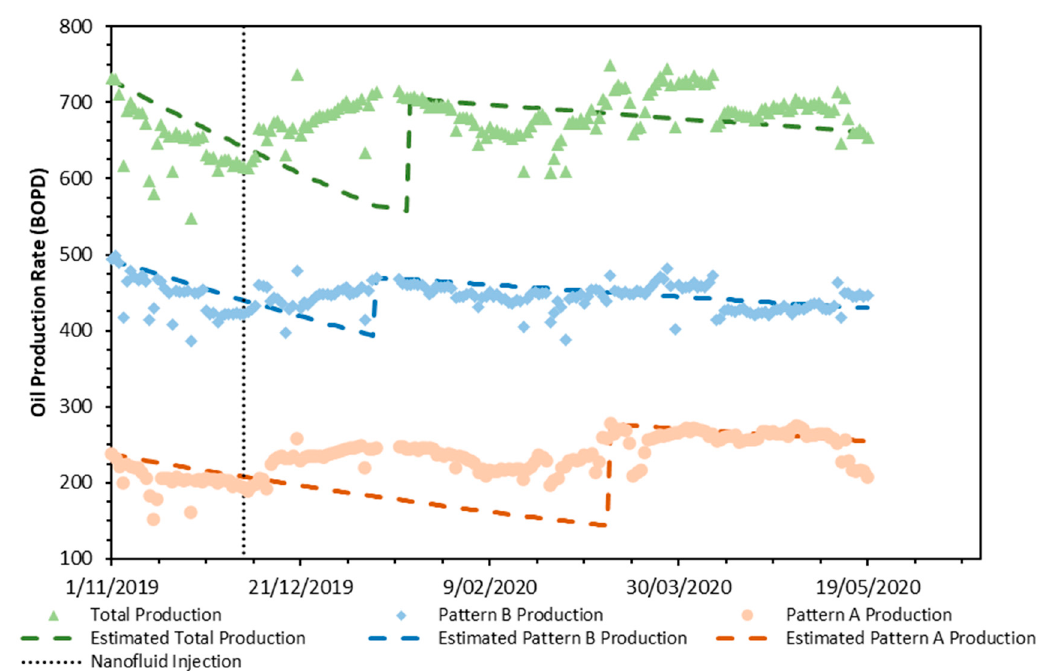
Figure 17. Real oil production rate registered for the patterns A and B and the total pattern of daily production. The symbols denote the respective production rates while the dashed lines represent production decline.